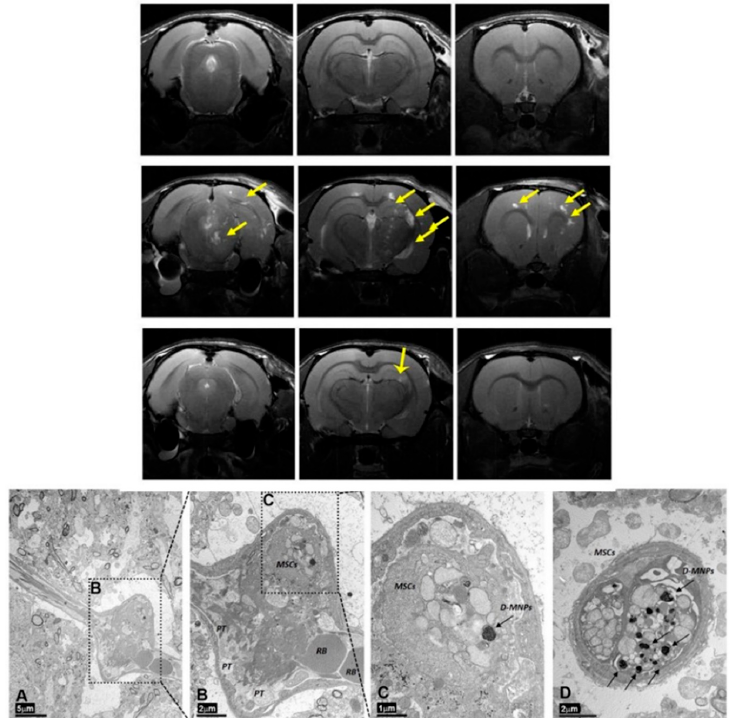
Figure 12. Upper figure: Multifocal ischemia is observed across the brain after administration of 1 × 10 6 MSCs (indicated with yellow arrows). Lower figure. Electron transmission micrograph of the rat brain cortex 4 h after intra-arterial (i.a.) delivery of MSCs with magnetic particles, showing the arterial occlusion caused by the cell administration. ( A ) Dilated brain vessel surrounded by neuropils (scale bar 5 µm). ( B ) Magnification of vessel dilation in A. Red blood (RB) corpuscles are on the right, and platelets (PTs) and MSCs can be observed inside the vessel (scale bar 2 µm). ( C ) Magnification of the upper vessel expansion in B (scale bar 1 µm). ( D ) Longitudinal section of a brain vessel in which two labeled cells can be observed (scale bar 2 µm). Reproduced with permission from [97], SpringerNature, 2017.